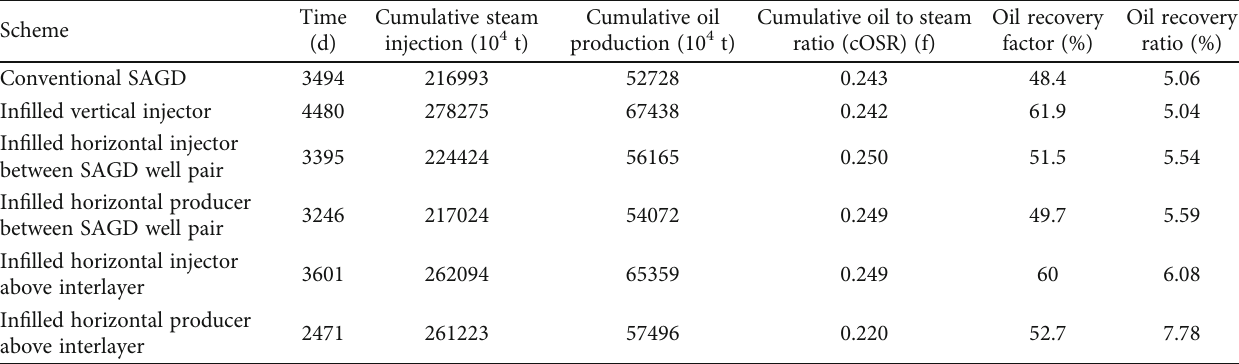
Table 5: Comparison of production characteristics for model